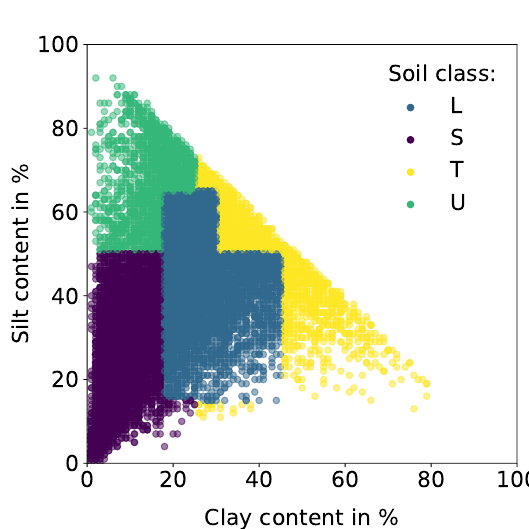
Figure 2. Clay and silt content of all pre-processed datapoints of the LUCAS dataset. The color of the datapoints symbolizes the respective soil class introduced in this paper.